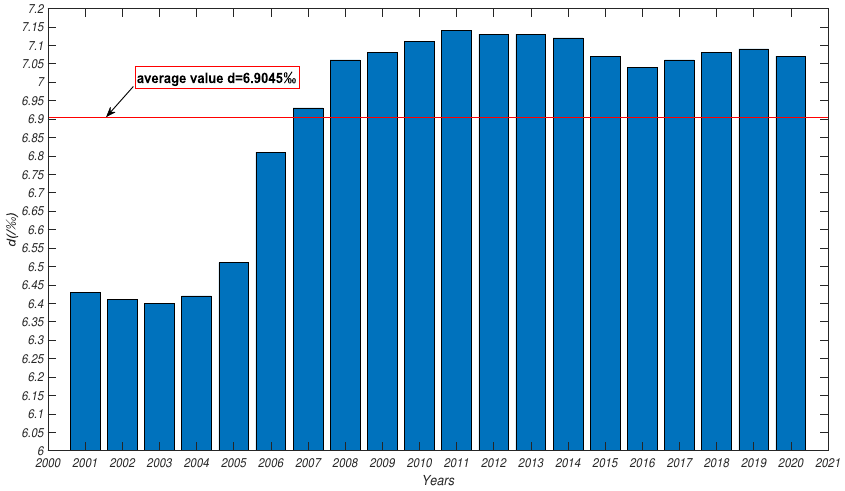
Figure 2. Annual natural mortality d in a low mortality